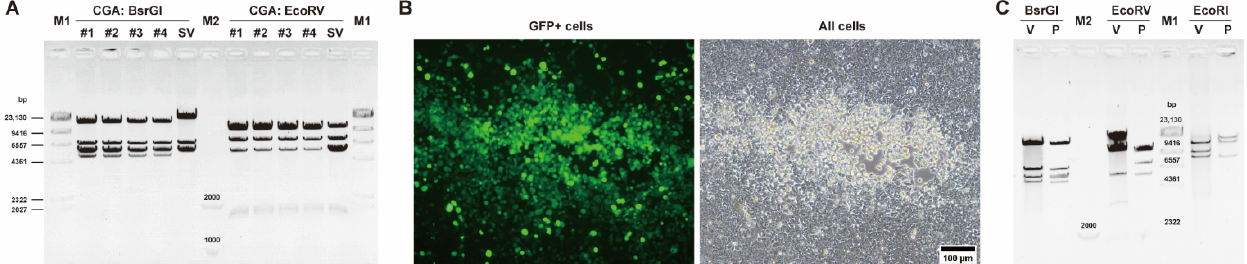
Figure 3. Rescue and identification of E3-deleted SAdV-1 vector. ( A ) Restriction analysis of E3-de-